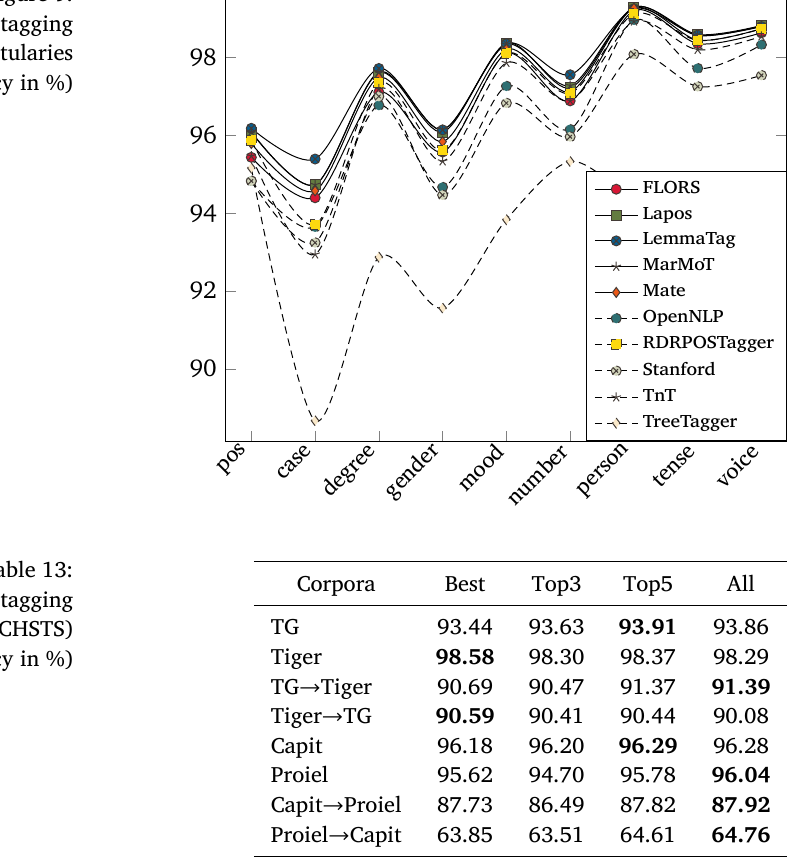
Fine-grained POS tagging of the Capitularies (accuracy in %)